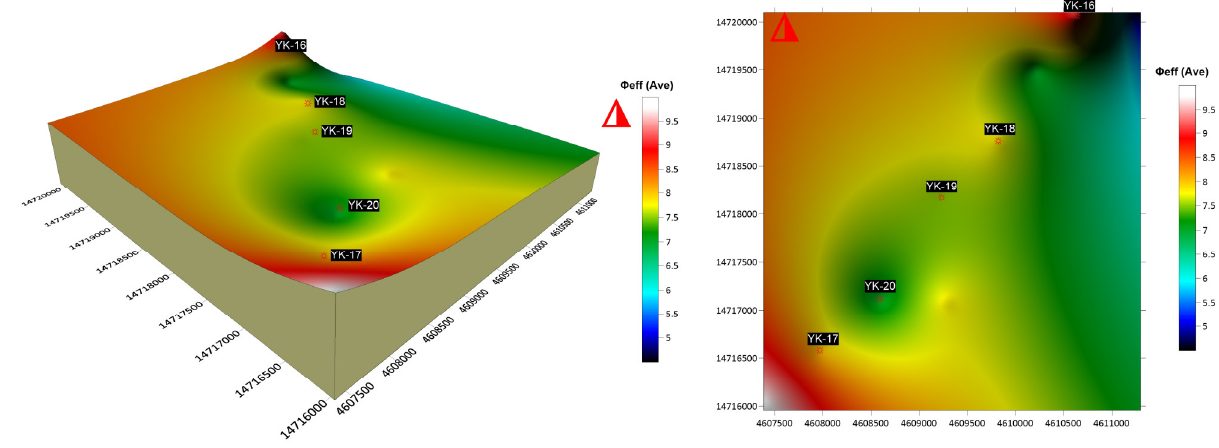
Figure 13. Φeff map (calculated in %). Figure 13. Φ eff map (calculated in %).